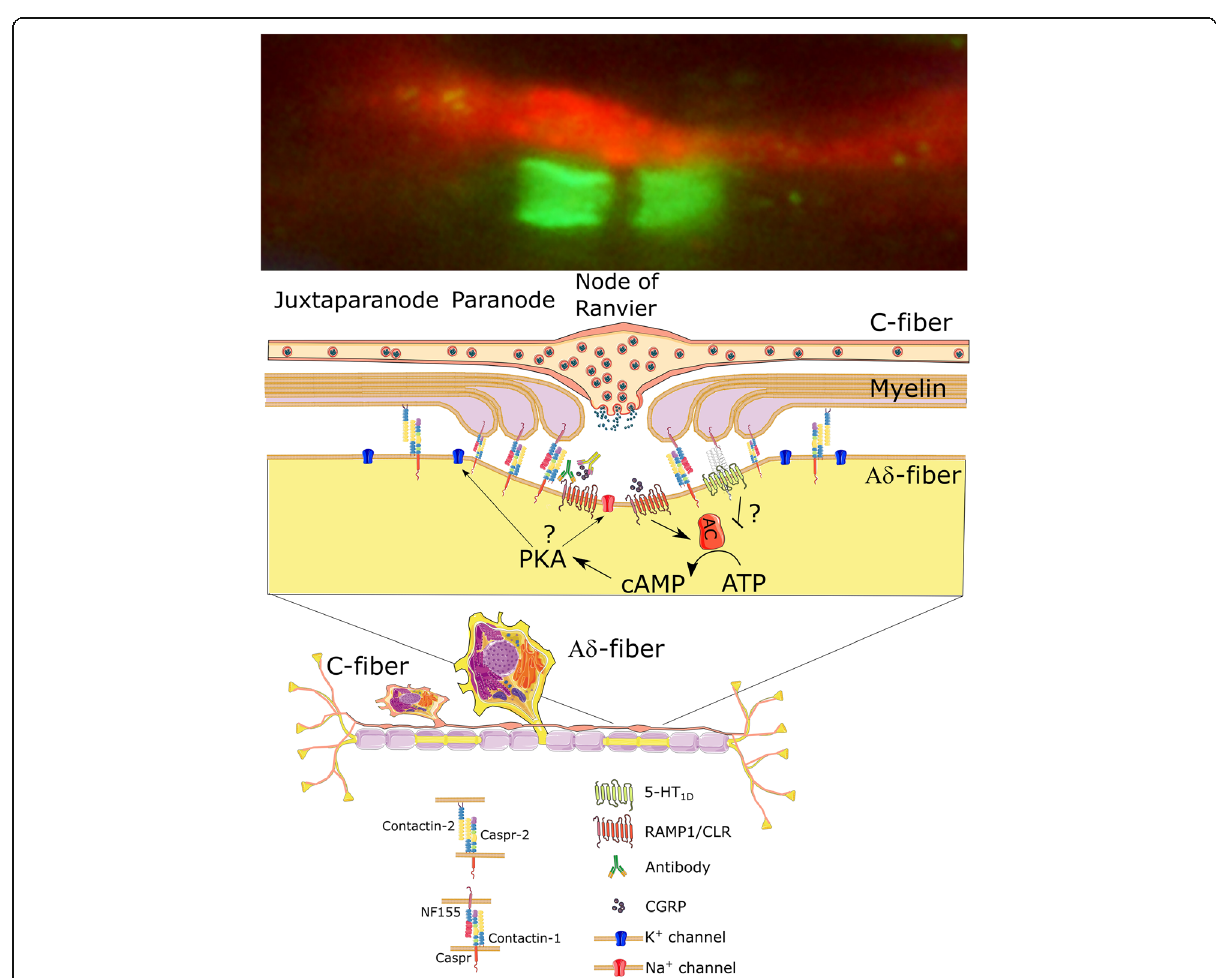
Fig. 7 Schematic overview of the possible modulation by C-fibers on adjacent A δ -fibers through axon-axon signaling at nodes of Ranvier in the trigeminal system. CGRP is released from the C-fiber bouton and diffuses into the node of Ranvier. Activation of the CGRP receptor causes increase in cyclic AMP, which could alter the conductivity of Na + or K + channels through Phosphokinase A (PKA). Furthermore, there is a possibility that 5-HT receptors could negatively modulate the cyclic AMP at the node. Alterations in Na + or K + channels could modulate the nodal threshold of activation. The schematic also includes a hypothesis on the mode of action of the anti-migraine antibody